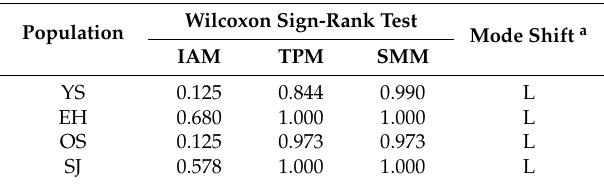
Table 4. Results of Wilcoxon’s heterozygosity excess test, the mode shift indicator for a genetic bottleneck in four Pacific cod populations.